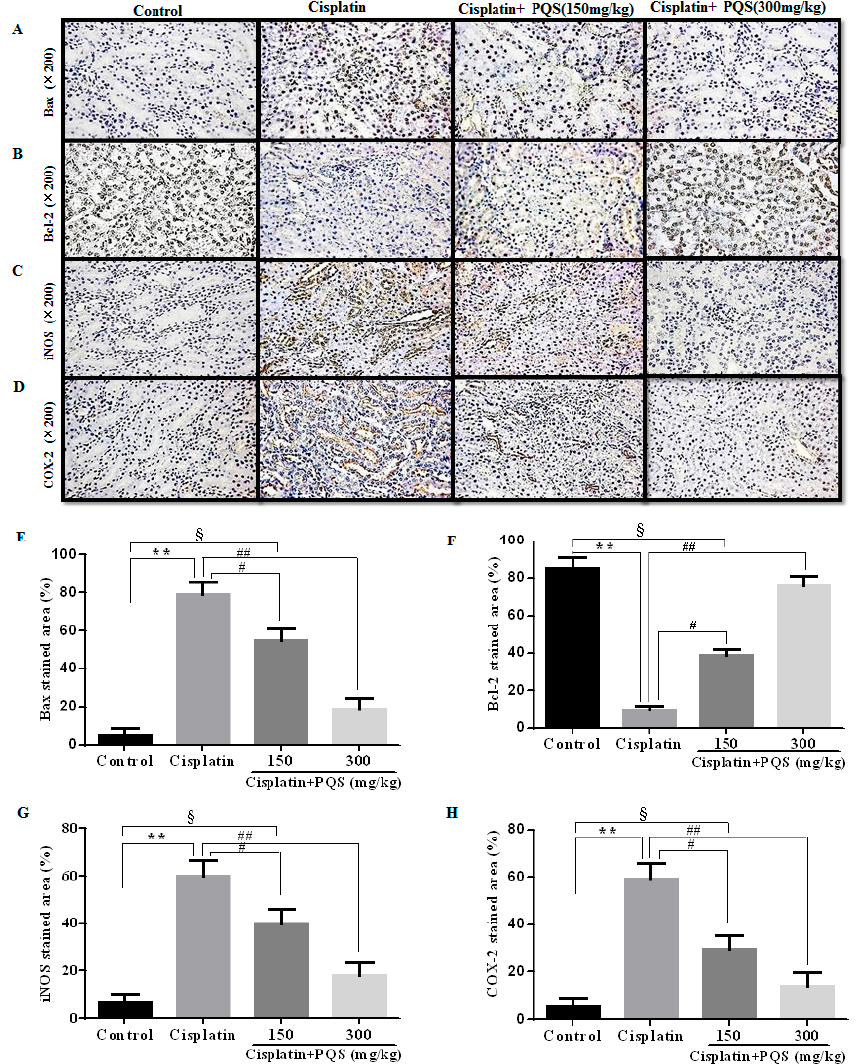
Figure 7. Effects of PQS on the expression of: Bax ( A ); Bcl-2 ( B ); inducible nitric oxide synthase (iNOS) ( C ); and cyclooxygenase-2 (COX-2) ( D ). Column chart show antibodies stained area of: Bax ( E ); Bcl-2 ( F ); iNOS ( G ); and COX-2 ( H ). The protein expression was examined by immunohistochemistry in kidney tissues from control, cisplatin, cisplatin + PQS (150 mg/kg), and cisplatin + PQS (300 mg/kg). § p < 0.05, ** p < 0.01 vs. control group; # p < 0.05, ## p < 0.01 vs. cisplatin control group. Notes: b-cell lymphoma-2 protein, Bcl-2; Bcl-2-associated x protein, BAX; bovine serum albumin, BSA.